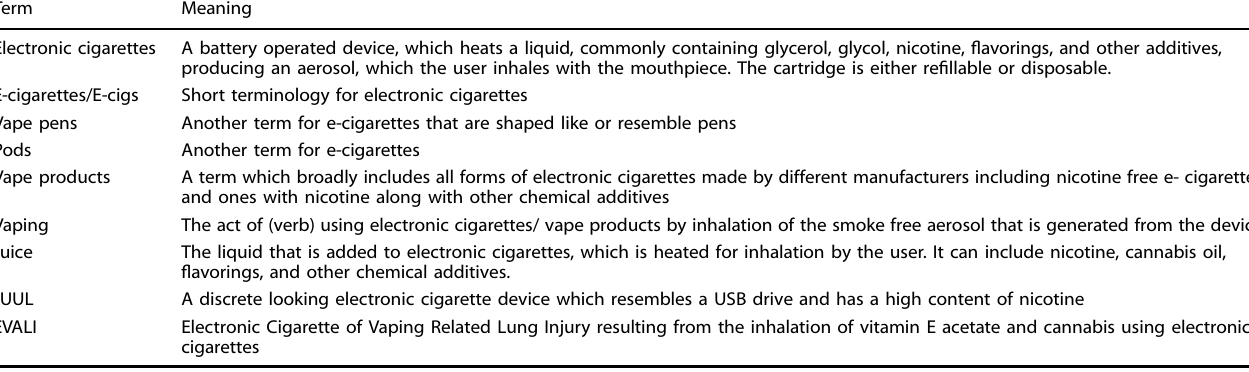
Table 1. Common electronic cigarette related terms 2 – 4,37,124,125 .